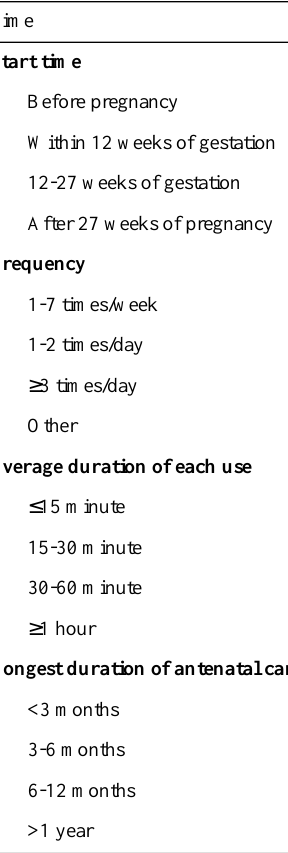
Table 6. Timing of using antenatal care apps.